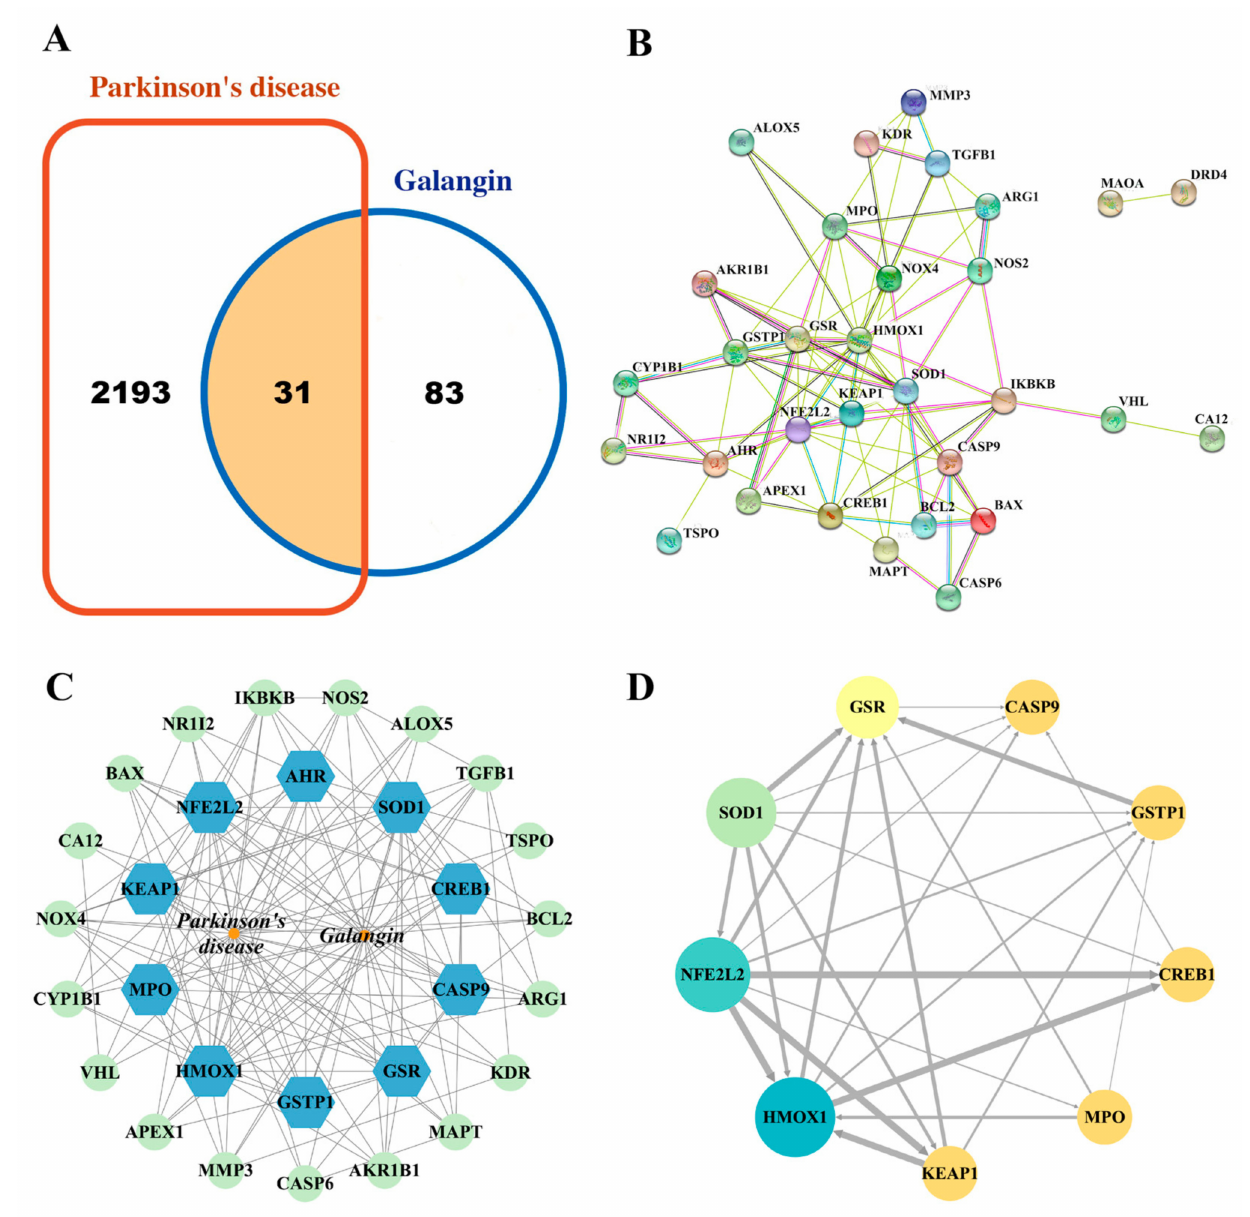
Figure 1. Network pharmacology analysis of galangin in PD. ( A ) Venn diagram of the common targets of galangin in PD. ( B ) The potential therapeutic targets were analyzed using the STRING database. ( C ) The construction of the galangin-target-PD network by the Cytoscape v3.7.1 software (Cytoscape Consortium, Seattle, WA, USA). ( D ) Protein–protein interaction (PPI) network based on the core targets of galangin against PD according to the screening conditions of Degree > 8, BC > 0.01815109, and CC >